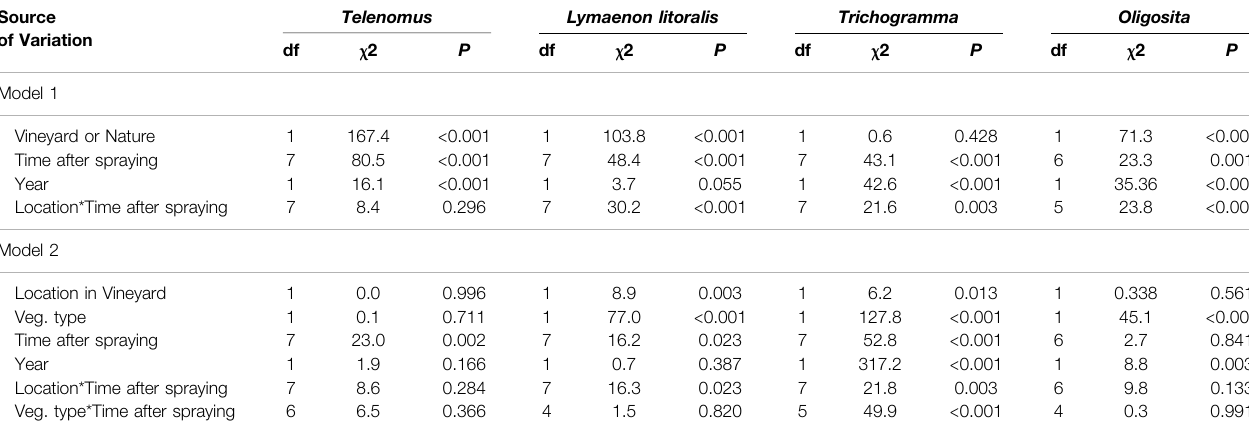
TABLE 3| Resultsofgeneralizedlinearmodelsoffactorsaffecting abundanceofthefourdominantwaspspecies. Model1included acomparison ofallvineyardlocationsto natural locations and model 2 compared vegetation types and locations within the vineyard. Source of Variation